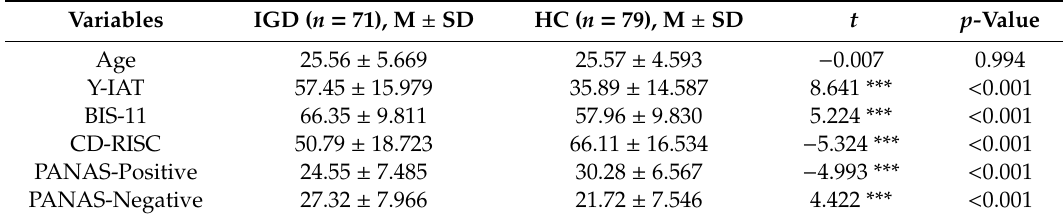
Table 1. Demographic and clinical characteristics.